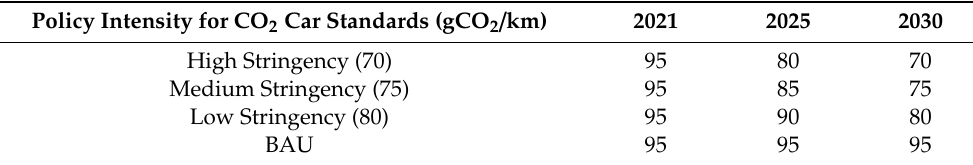
Table 2. Stringency of CO 2 car standards.